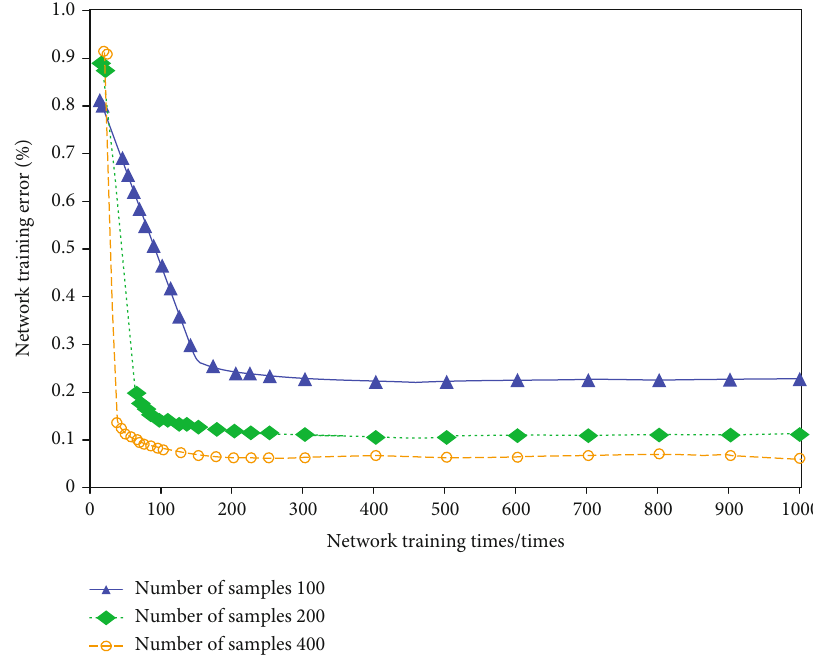
Figure 7: Network training error corresponding to di ff erent training times. Table 2: Algorithm and simulation time corresponding to di ff erent